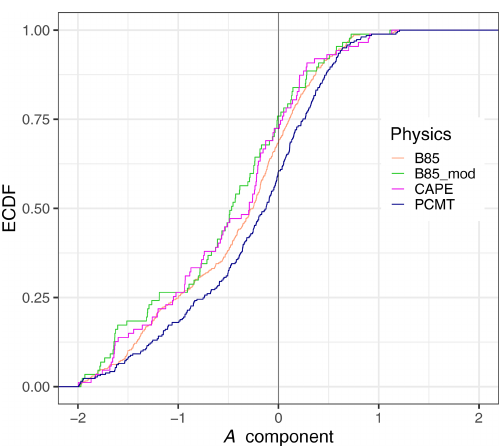
Figure 9. Empirical cumulative distribution function of the A com- ponent computed from cluster 2 at lead time LT34 for the four classes of physics